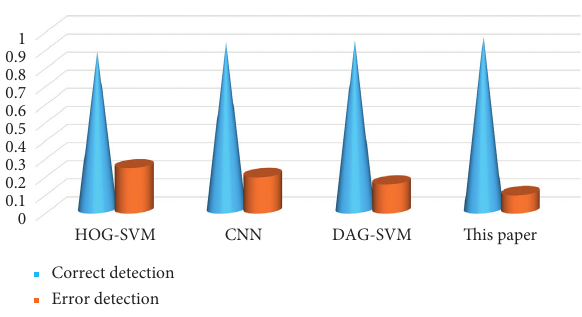
Figure 9: Test results on Caltech